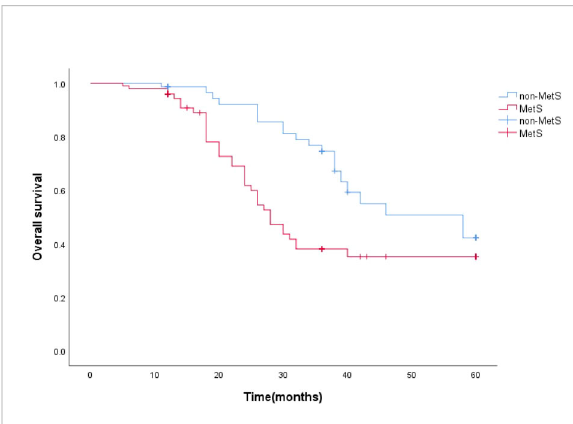
FIGURE 4 3-year survival curves for mPCA patients with MetS and non- MetS.